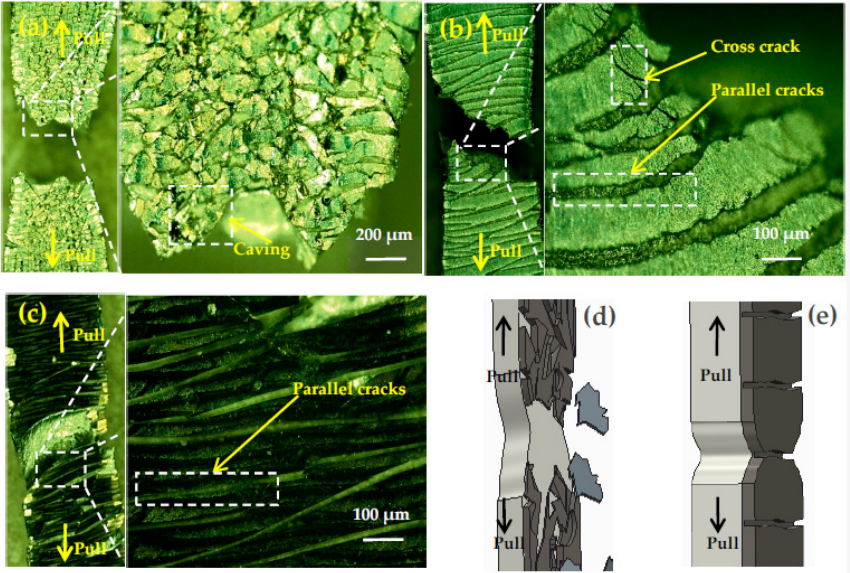
Figure 9. The tensile specimen coating surface morphology of sample No. 1 ( a ), sample No. 4 ( b ), sample No. 6 ( c ), schematic diagram of brittle fracture ( d ) and ductile fracture ( e ).